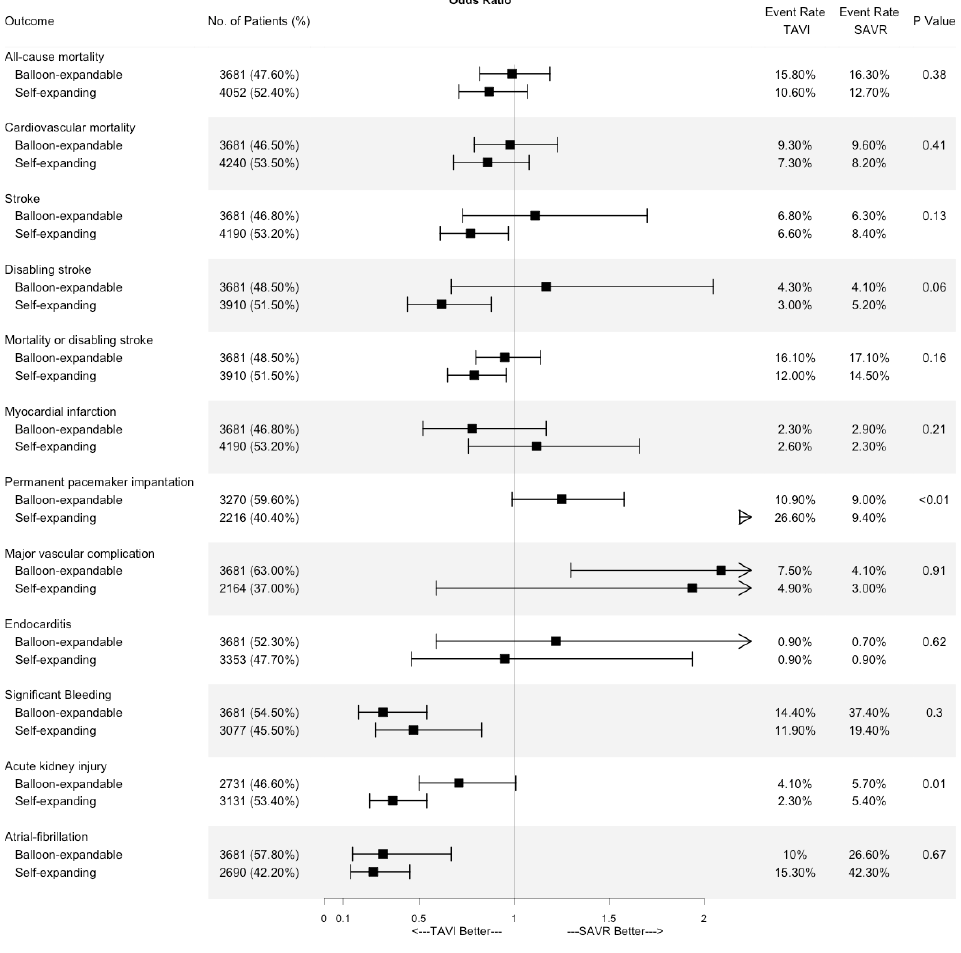
Figure 5. Subgroup analysis for main outcomes according to TAVI valve system. Range represents Odds Ratio and 95% confidence interval.